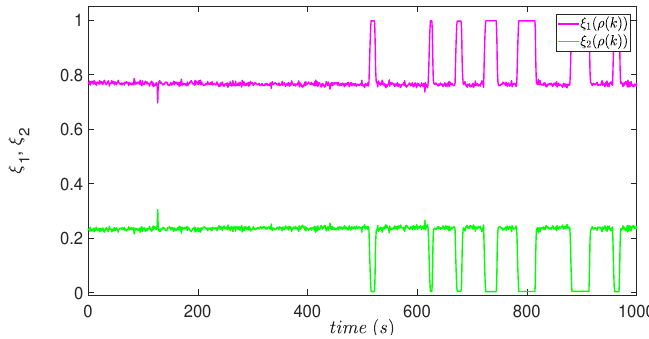
Figure 13. Membership